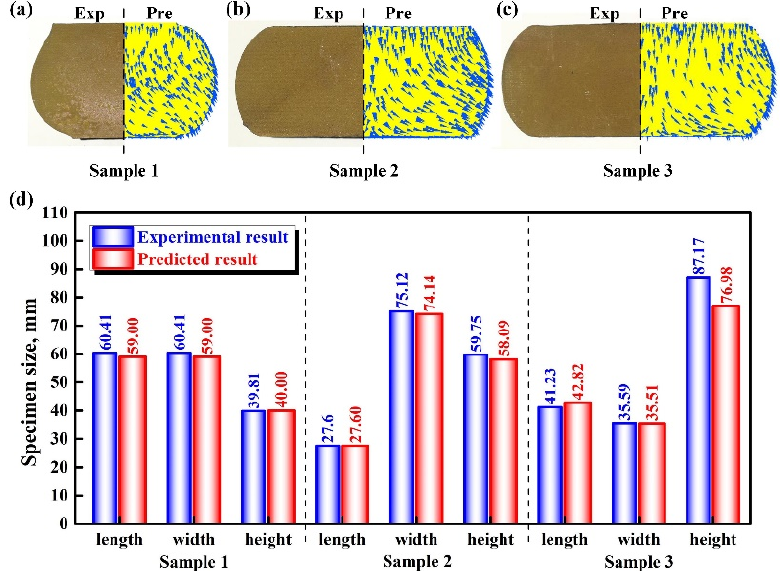
Figure 8. Experimental and simulated specimen sizes after MDF. ( a ) sample 1, ( b ) sample 2, ( c ) sample 3, ( d ) three-dimensional comparison.